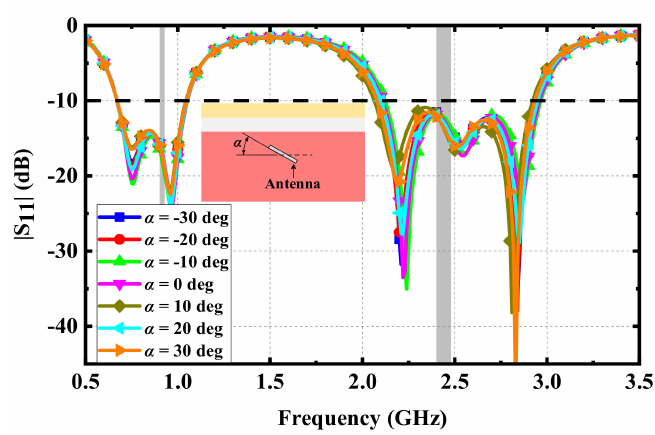
Figure 6. Simulated |S 11 | varying with the incline angles of implantation.